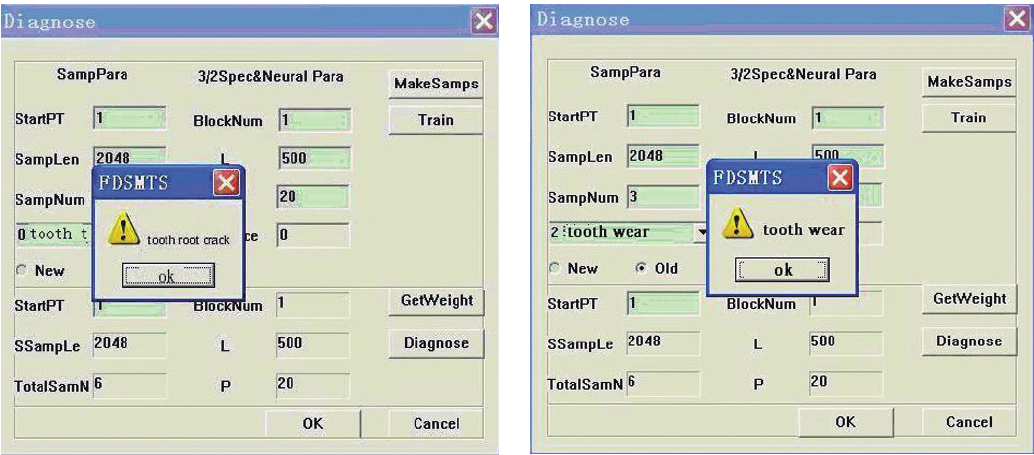
Fig. 17. Detection and diagnosis result display interface of the VI